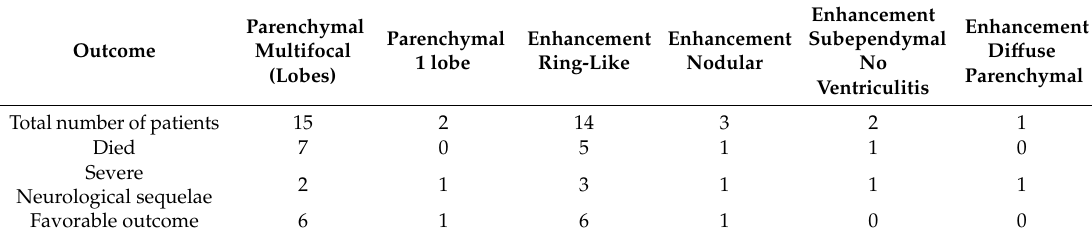
Table 4. Focal and multifocal involvement, enhancement pattern, and